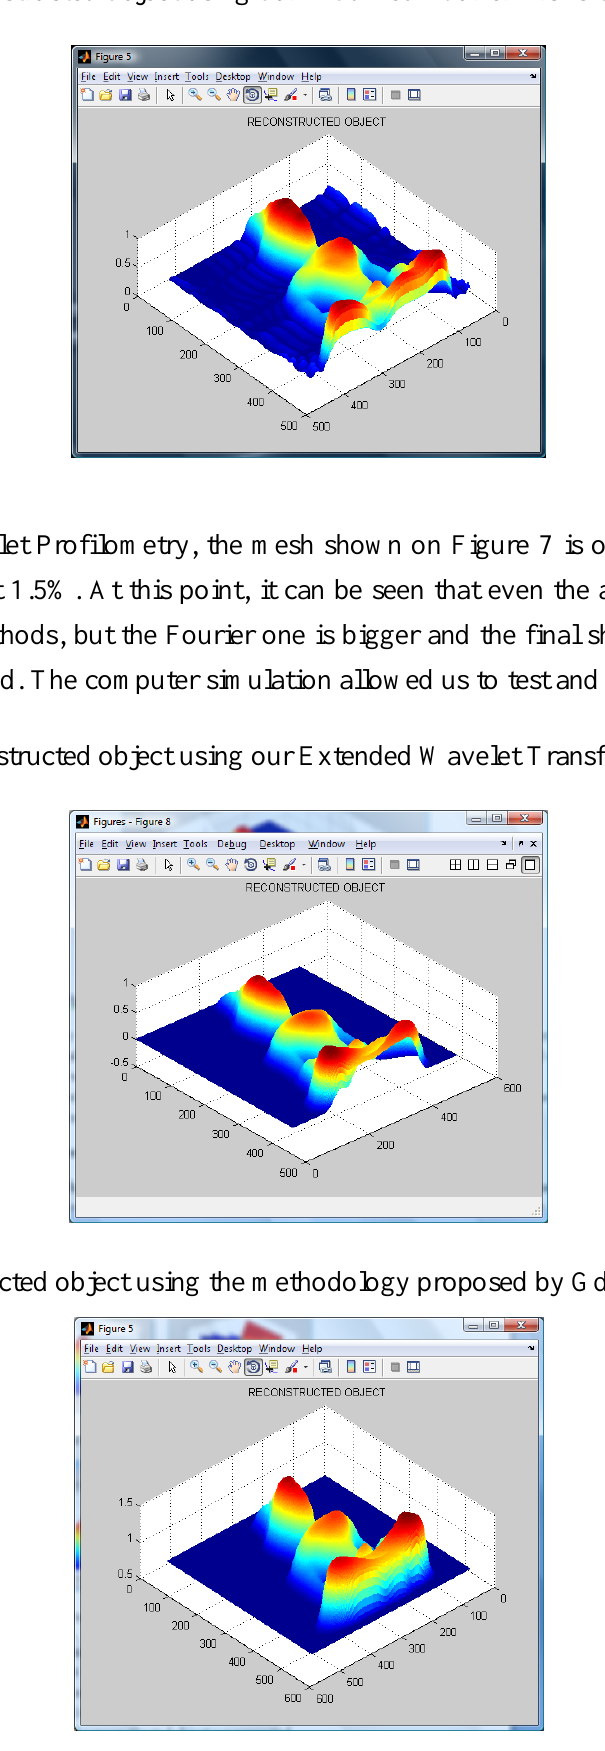
Figure 6. Reconstructed object using our Modified Fourier Transform Profilometry.